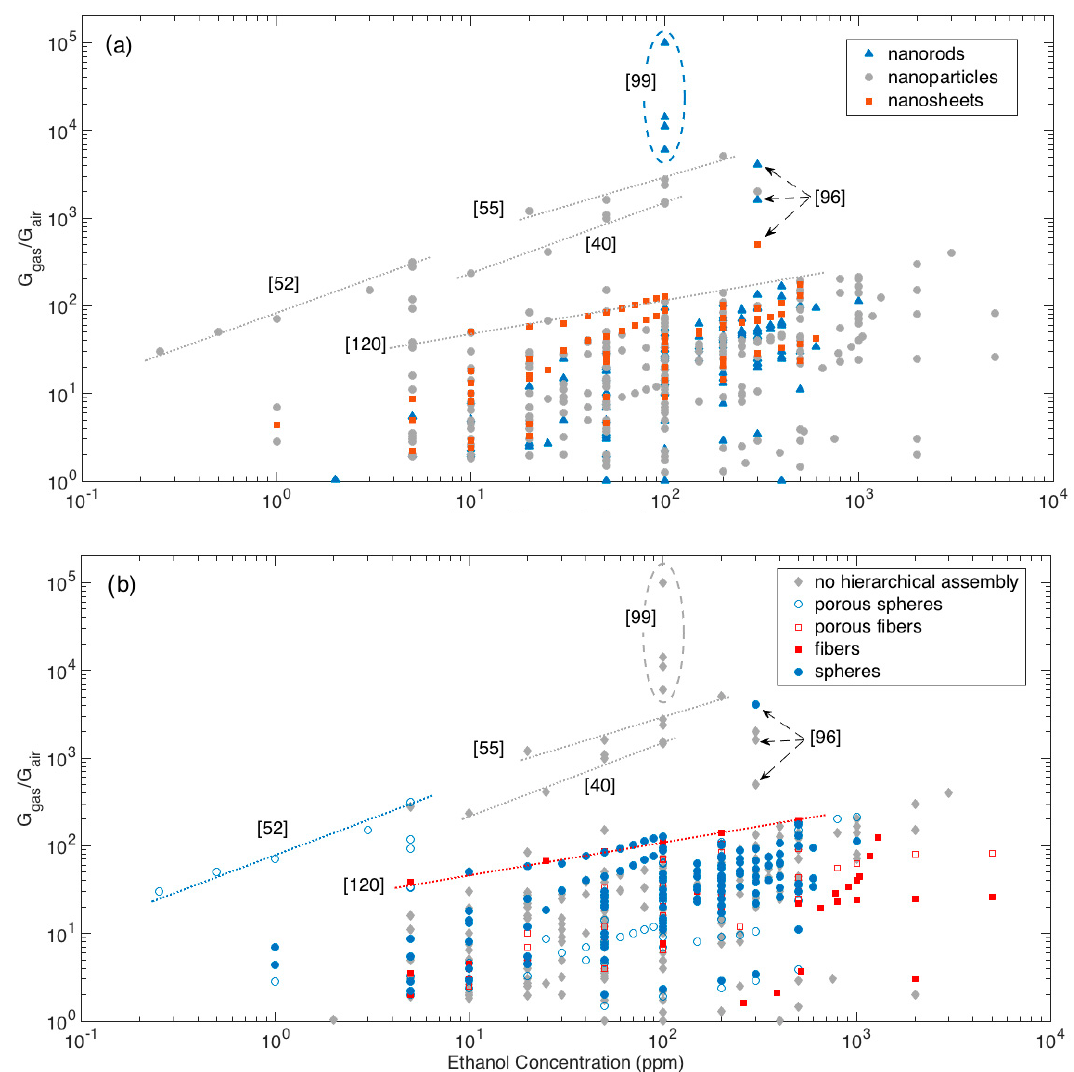
Figure 5. Response amplitude vs ethanol concentration plot, different colors highlights the dependence from elementary building blocks ( a ) and from the assembly of elementary building blocks ( b ). For some particular data-points, the related references are also identified to support the discussion (see text for details).